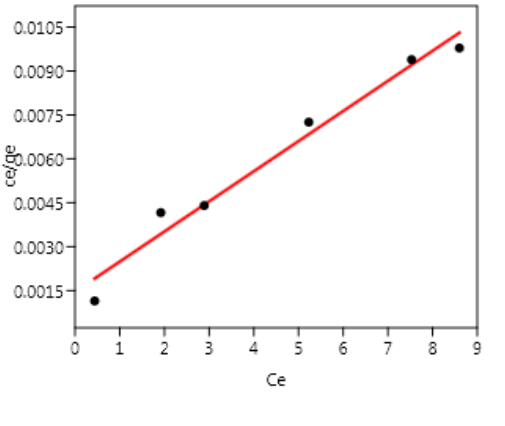
Rezaei H, et al. Isothermal and Kinetic Evaluation of Adsorption Fish Farm Effluents. J Adv Environ Health Res. 2021;